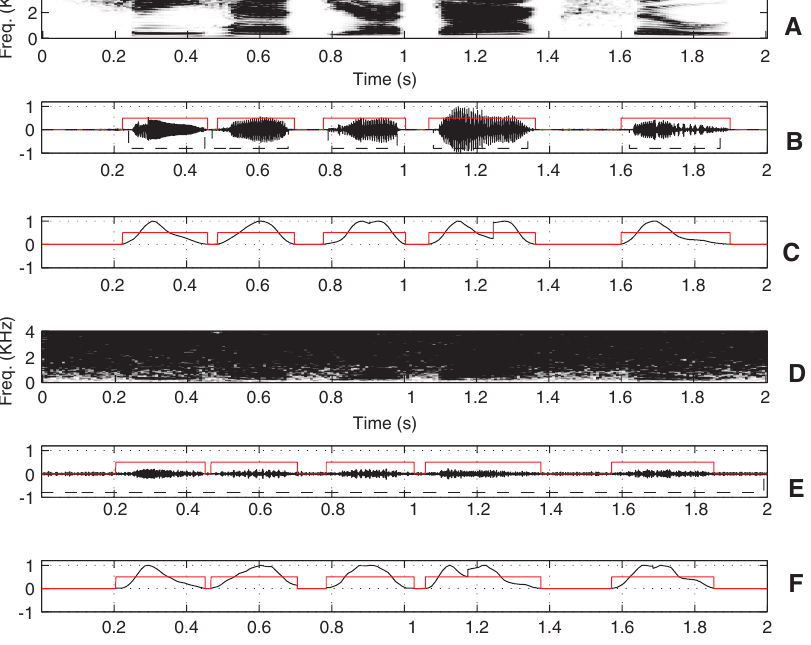
Figure 5. The Performance of EMD-Based VAD for Clean Speech and Noisy Speech (a 0-dB White Noise was Added to Clean Speech): (A) Spectrogram of Clean Speech, (B) CIMF After EMD of Clean Speech, EMD-Based Decision Function (Red) and Energy-Based Decision Function (Dotted Line in Black), (C) Energy Curves (Black) and Decision Function (Red), (D) Spectrogram of Noisy Speech (Clean Speech+0-dB White Noise), (E) CIMF After EMD of Noisy Speech, EMD- Based Decision Function (Red) and Energy-Based Decision Function (Dotted Line in Black), and (F) Energy Curve (Black) and EMD Based Decision Function